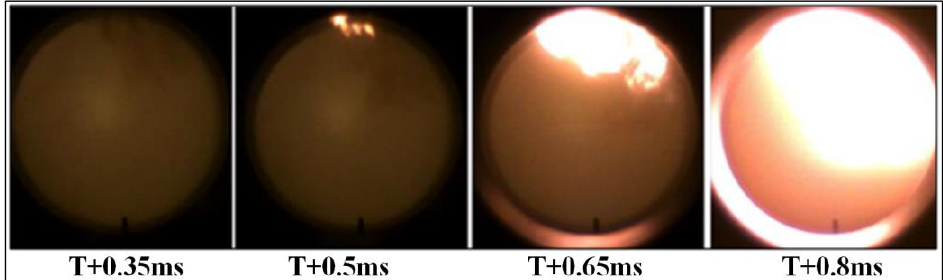
Figure 17. The initialization of the ignition and the displacement of the flame front in the chamber with a swirl environment.